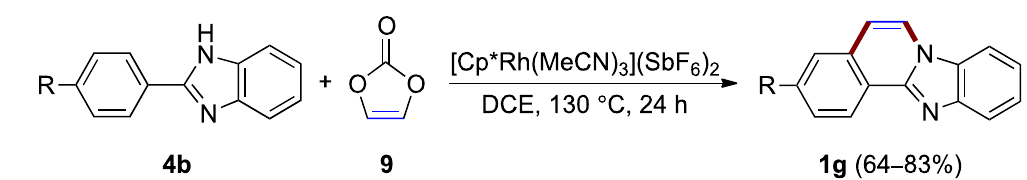
Figure 8. Application of vinylene carbonate 9 in rhodium-catalyzed oxidative annulation of 2-arylbenzimidazoles 1g .